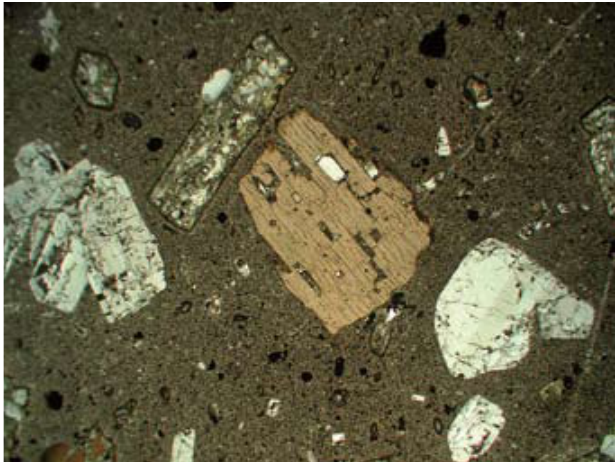
Figure 8. Microphotograph of the conduit lava, showing hydrothermal alteration. The groundmass is cryptocrystalline (devitrified), and hornblende (upper left) is replaced with assemblage of chlorite, carbonate, and rutile, contrasting to fresh biotite crystal (center). The field of view is about 2 mm